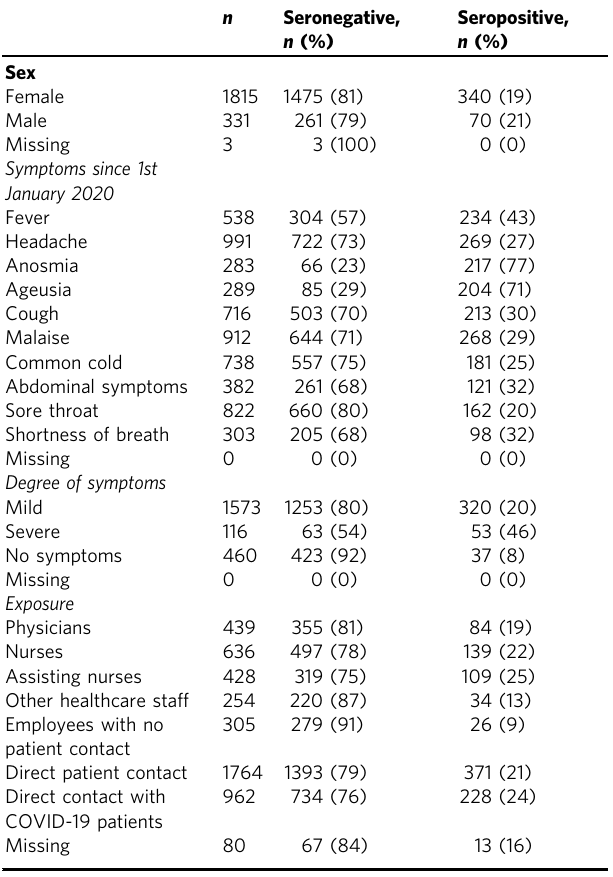
Source data are available as Source Data fi